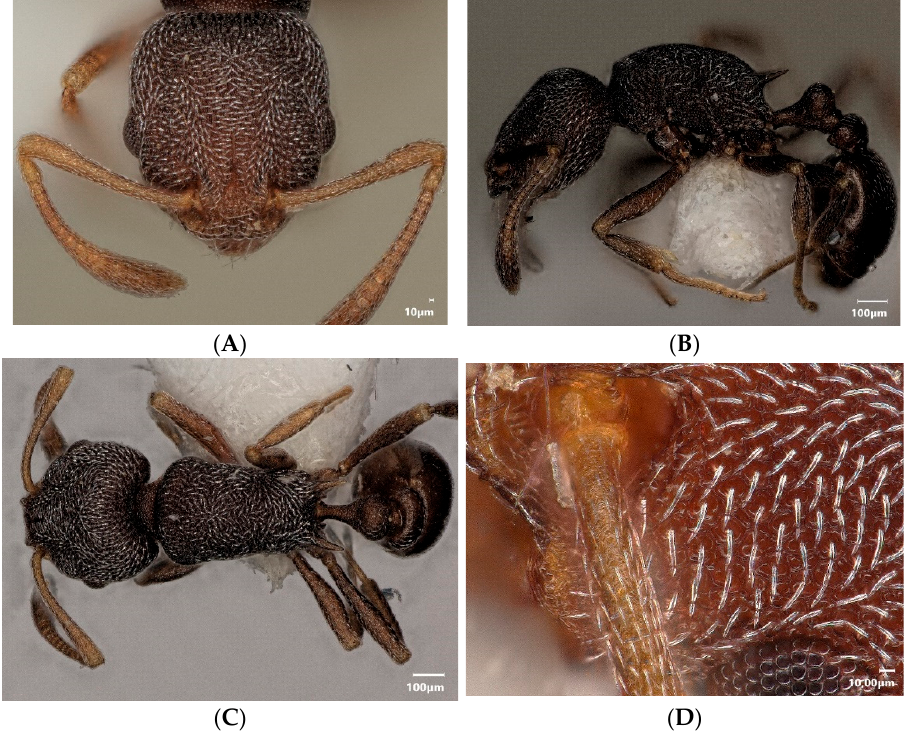
Figure 9. Cardiocondyla parvinoda : head in dorsal view ( A ), lateral view ( B ), dorsal view ( C ).